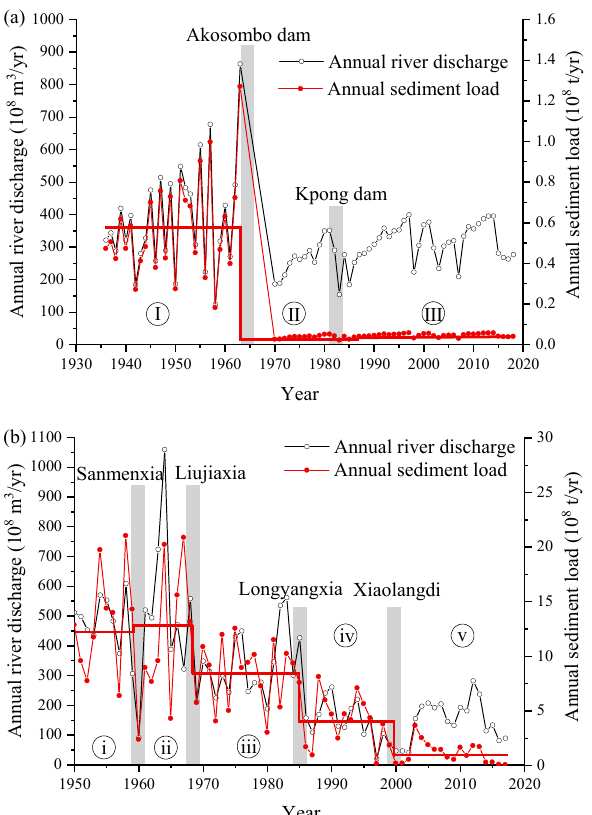
Figure 3. The trend of change of annual river discharge and sediment load in ( a ) the Volta River Delta for three phases: phase I (1936–1963), phase II (1964–1982) and phase III (1983–2018); and ( b ) the Yellow River Delta for five phases: phase i (1950–1960), phase ii (1961–1968), phase iii (1969–1985), phase iv (1986–1999) and phase v (2000–2017).